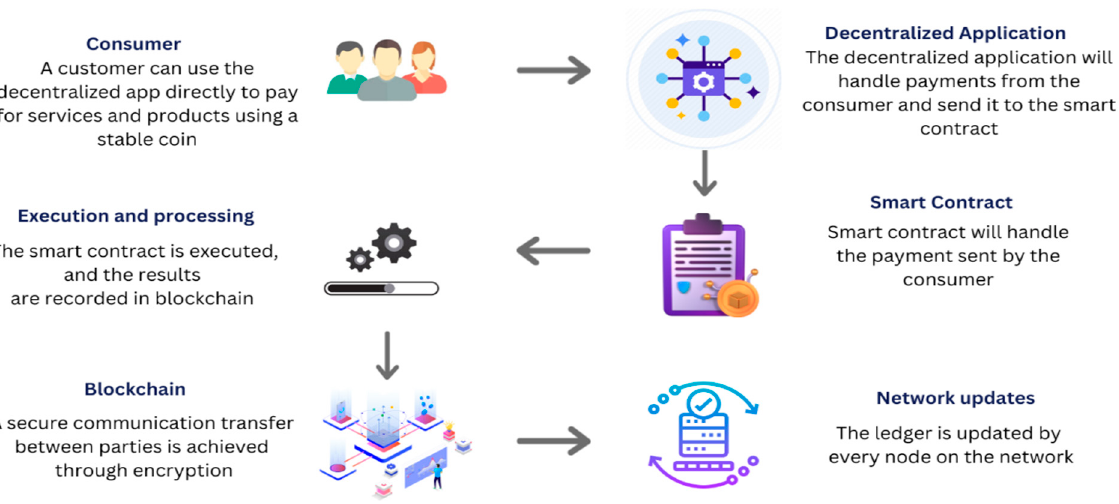
Figure 2. Proposed Smart Contract for Data Sharing and Secure Payment in Consumer Electronic Applications.